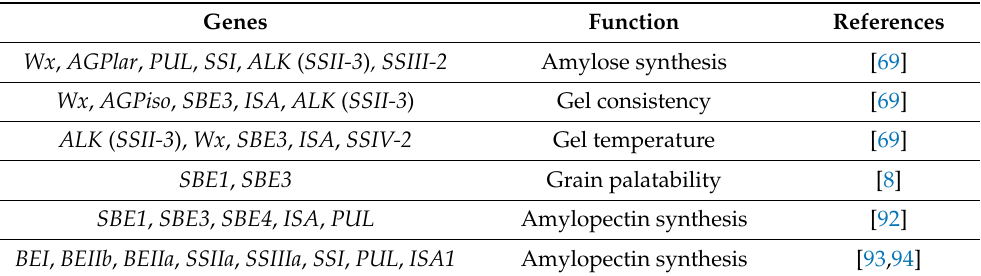
Table 1. Genes involved in starch modification.